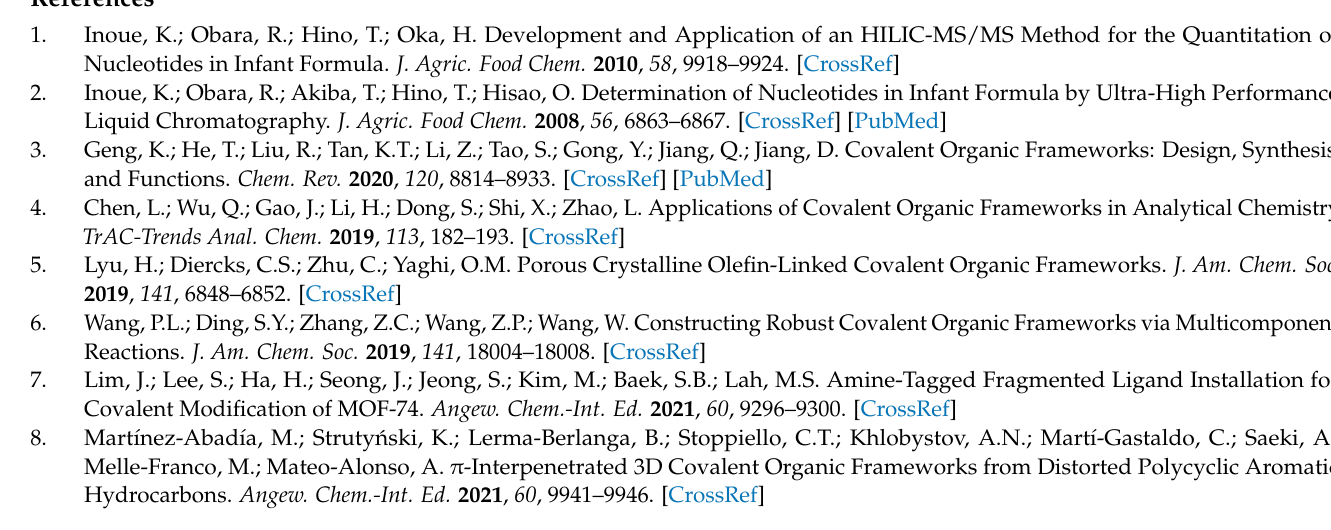
Figure S2: Chromatograms of five nucleotides after SPE treatment of blank and blank spiked